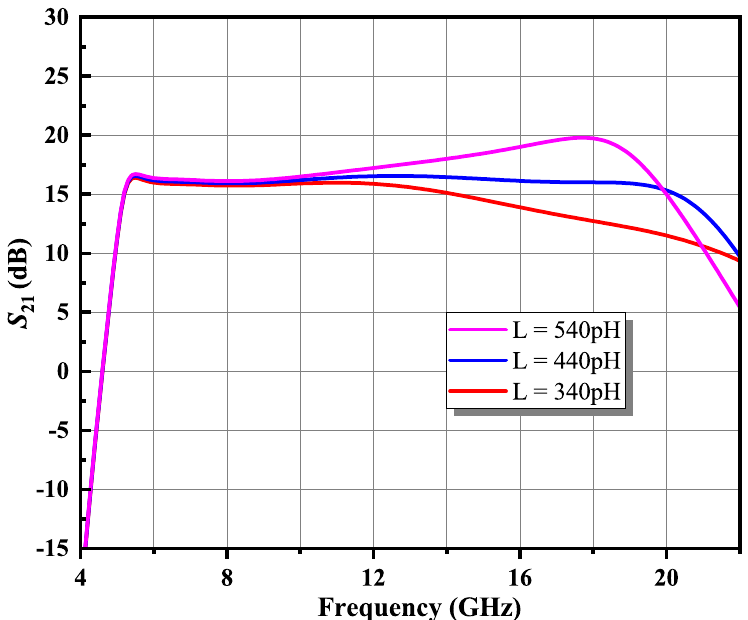
Figure 3. Simulation of the dependence of the S 21 for different feedback inductance values.